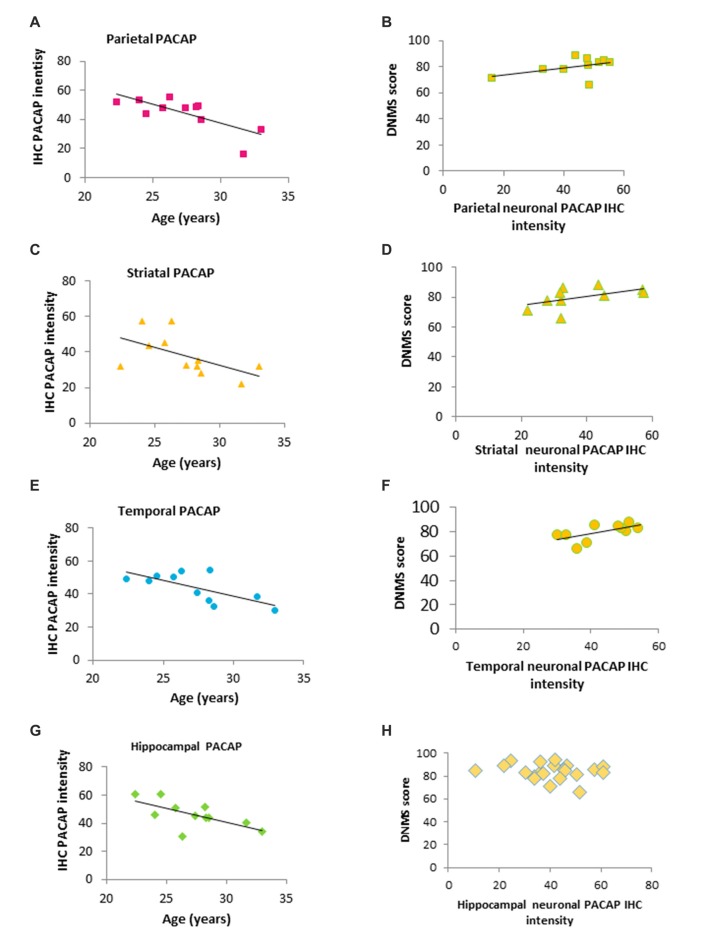
Correlation of age, PACAP and DNMS performance in old rhesus macaques. (A,C,E,G) Regional IHC intensity of neuronal PACAP in the old group of rhesus macaques (20–32 years). PACAP levels in all four regions (the hippocampus, parietal lobe, striatum and temporal lobe) declined with age progression. (B,D,F,H) Higher levels of regional PACAP correlated with better performance on the DNMS task in the old group of monkeys in Parietal (B) Striatal (D) and Temporal lobe (F) while no correlation was found in the hippocampus (H).